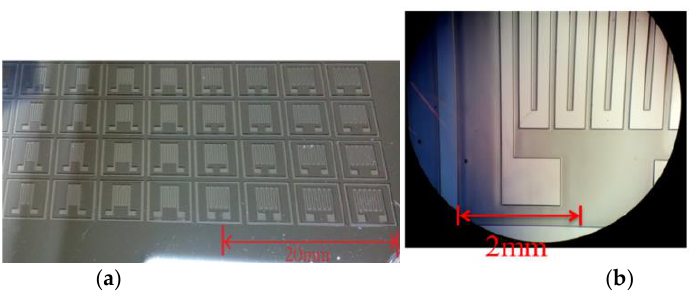
Figure 3. ( a ) Silicon mold and ( b ) optical microscope image of mold for strain sensor fabrication.